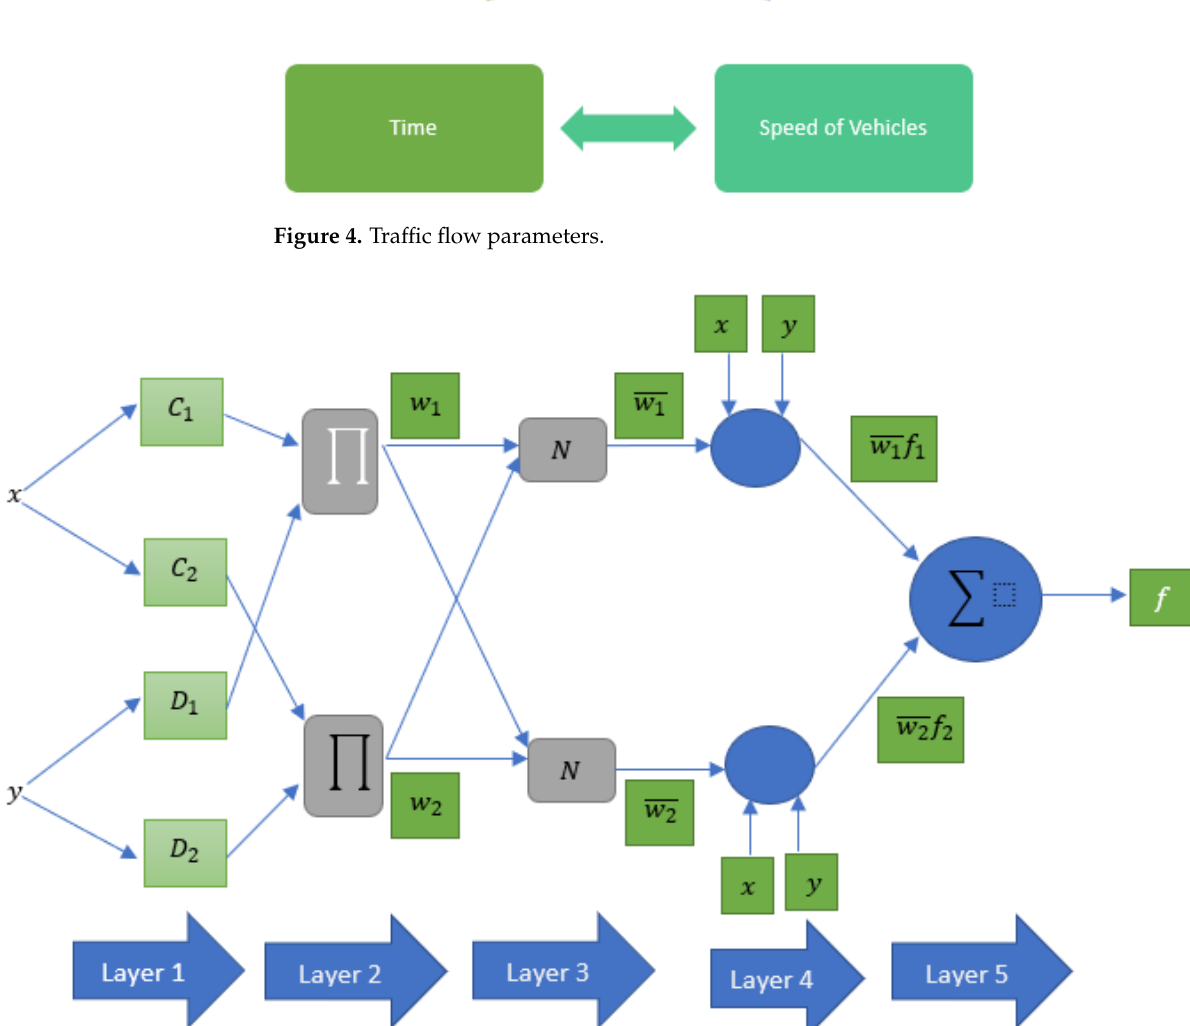
Figure 5. A typical structure of an ANFIS model. Layer 1